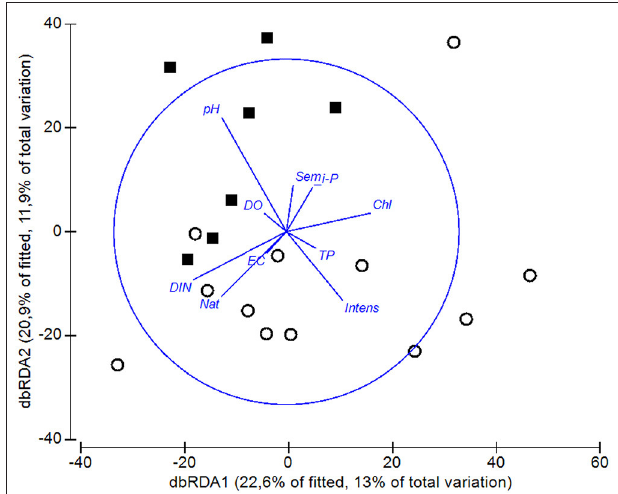
FIGURE 6 | Distance-based RDA ordination relating the explanatory variables with the macroinvertebrate assemblages, using the Bray-Curtis similarity index. The length and direction of the vectors represent the strength and direction of the relationship. DO is dissolved oxygen concentration, EC is electrical conductivity, TP is total phosphorous concentration, Chl is chlorophyll-a concentration, DIN is dissolved inorganic nitrogen concentration, i-P is dissolved inorganic phosphate concentration. For the land-use variables, Nat is the percentage area of native vegetation, Sem is the percentage area of seminatural pasturelands, and Intens is the percentage area of intensive pasturelands. Squares indicate the artificial tanks and open circles the natural